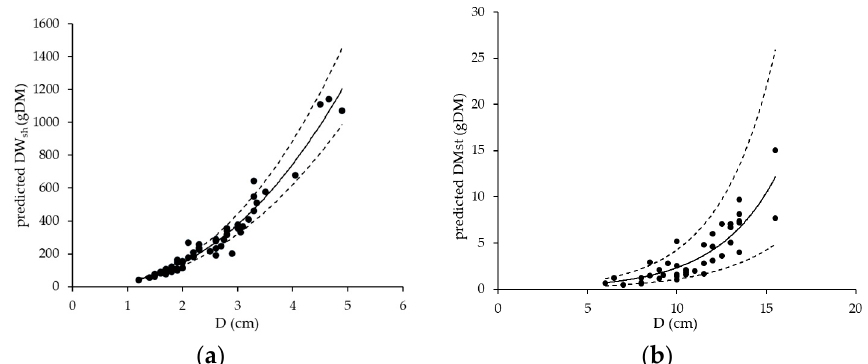
Figure A1. Allometric equations estimated (lines) and real values (points) for: ( a ) poplar shoots; ( b ) poplar stumps. Table A3. Poplar growth characteristics in the two systems (average ± SE; ACS: Alley Cropping System; SRC: Short Rotation Coppice system).